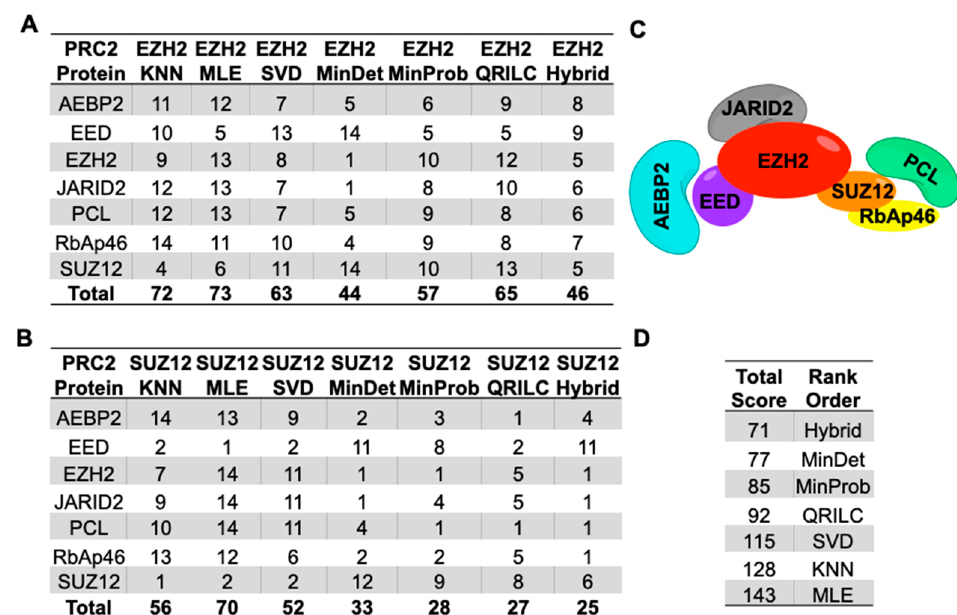
Figure 5. Rank ordering of PRC2 component IPs. Each component of the PRC2 complex identified in EZH2 ( A ) and SUZ12 ( B ) IPs were rated (1–14) according to position in the rank-ordered protein lists (Supplemental Table S1). ( C ) Canonical human PRC2 protein complex, adapted from Margueron, R., 2011, The Polycomb Complex PRC2 and its Mark in Life. Nature, 2011. 469(7330): p. 343–9 ( D ) Total ratings and overall ranking of each method.